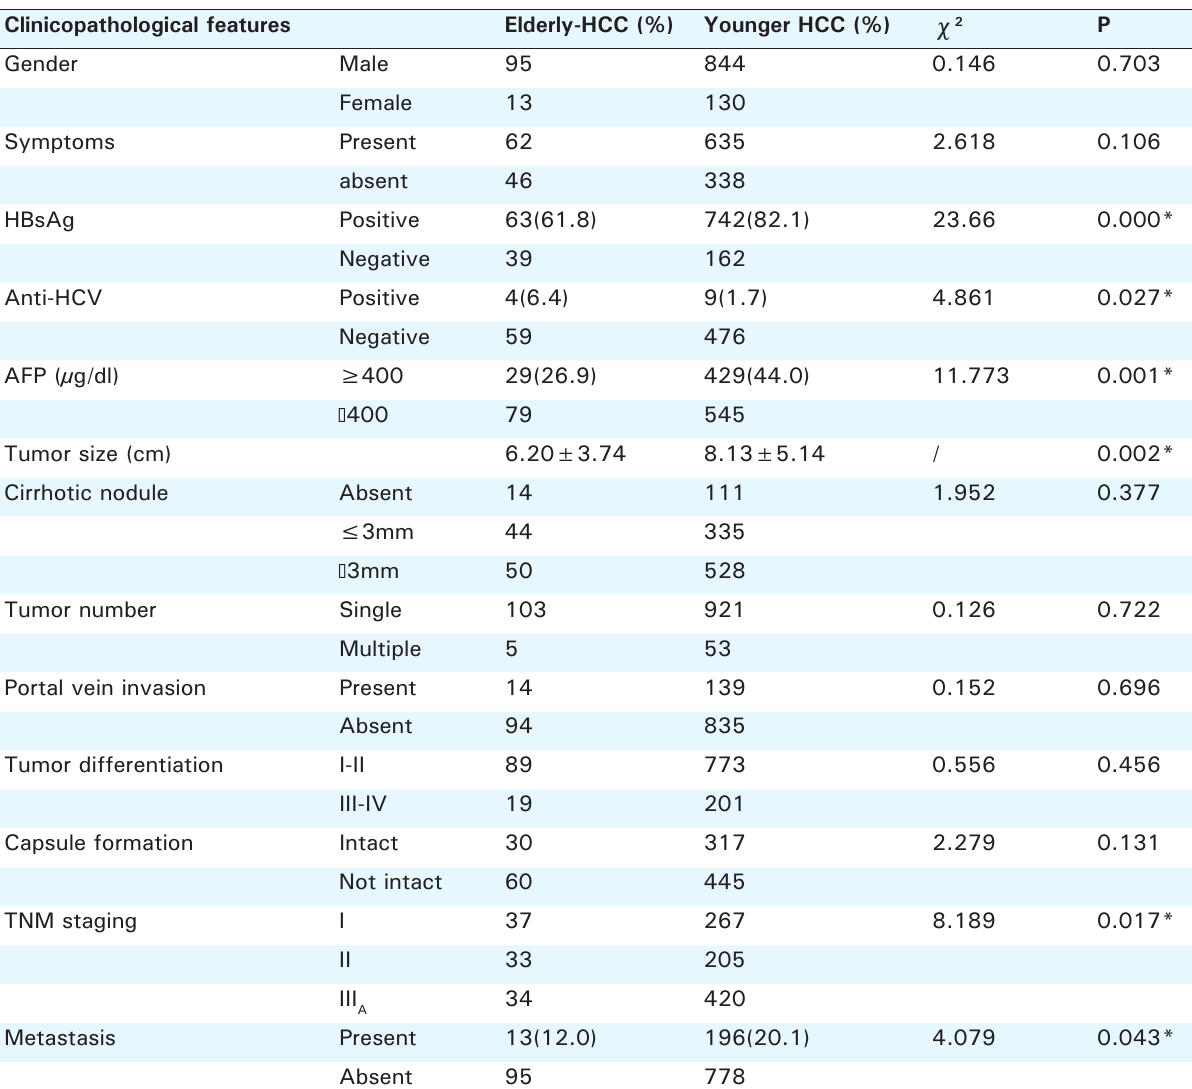
Table 1. Clinicopathological Features of the Elderly and Younger HCC Patients Clinicopathological